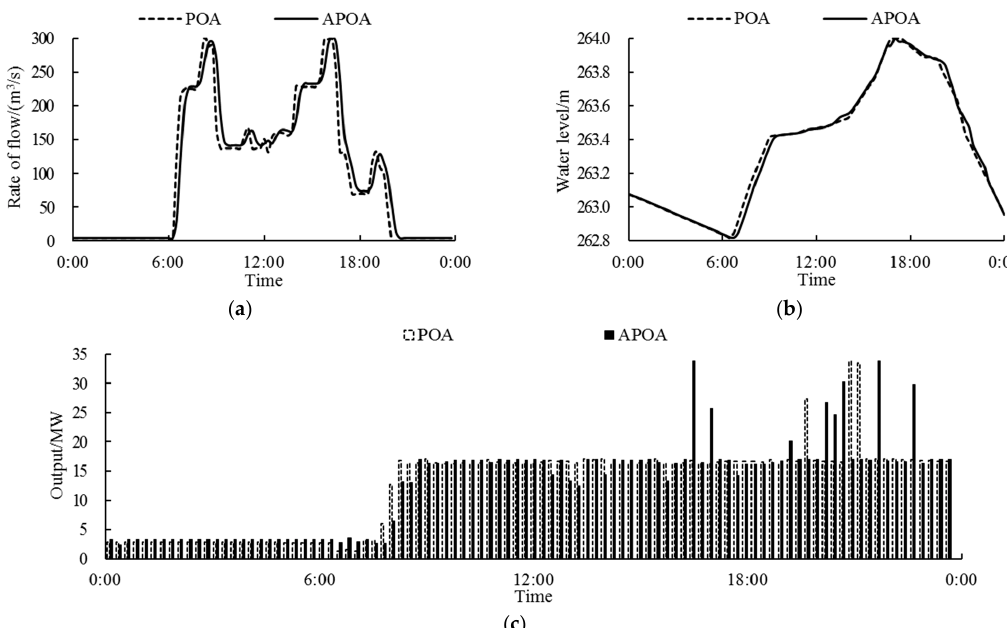
Figure 9. Comparison of Xiaoxuan’s calculated results between POA and APOA. ( a ) Xiaoxuan’s